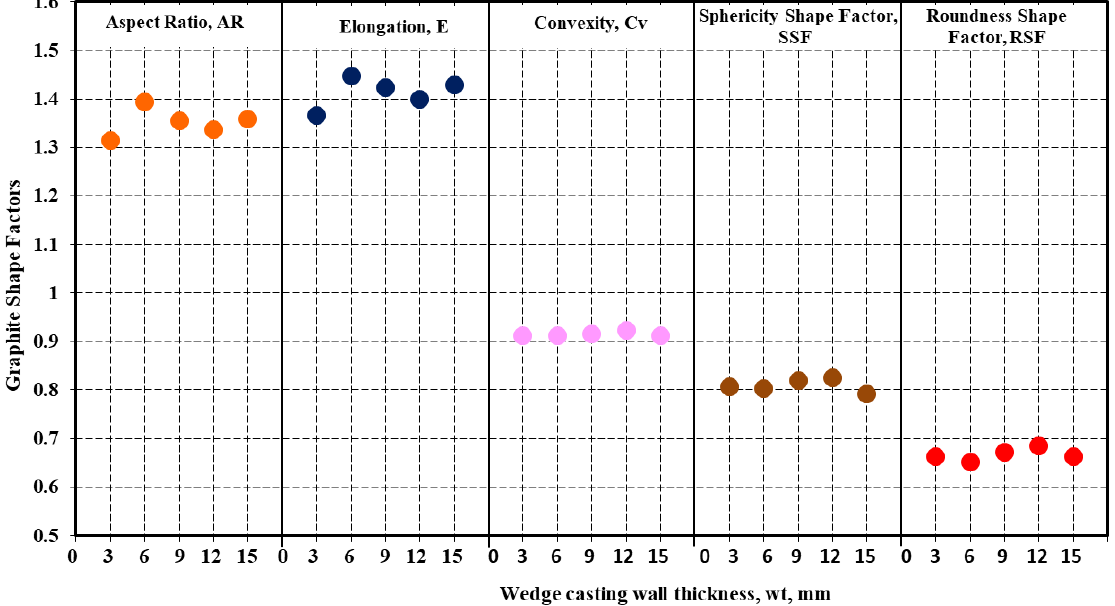
Figure 9. Graphite shape factors as an influence of the wedge casting wall thickness influencing factor.